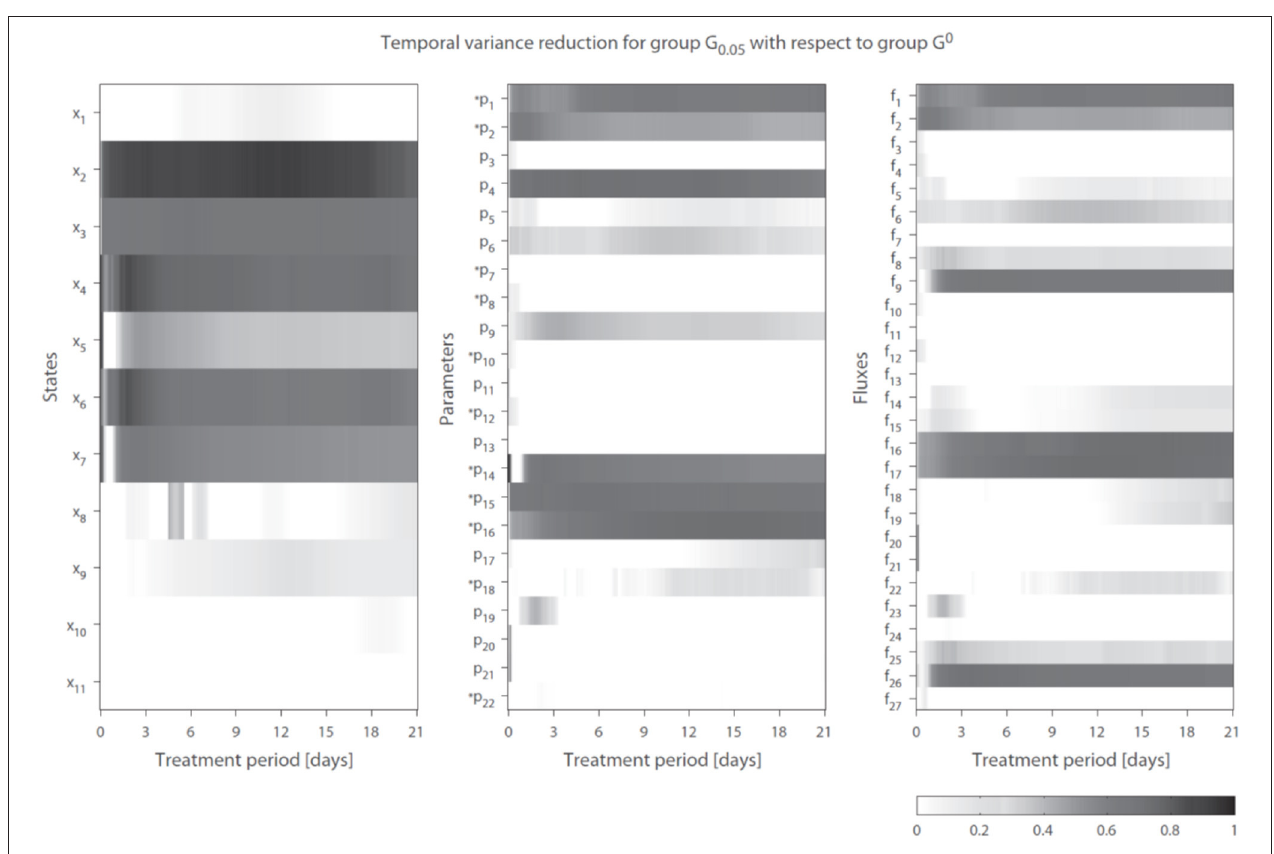
FIGURE 4 | Temporal variance reduction by incorporating gene expression data. The gray-intensity indicates reduction in variance for estimated state variables (left) , parameters (middle) , and fluxes (right) . The asterisk signs (*) indicate parameters that were coupled to one or multiple genes. The (dark-)gray parts display model estimates that were effectively constrained by the gene expression data. Results shown for group G 0.05 , containing 5 % of the trajectory solutions with the highest ). Compared to G0, which are the solutions obtained without temporal correlation between parameter trajectories and gene expression (lowest penalty by χ 2 g 1 regularization Note f 14 = f 28 + f 29